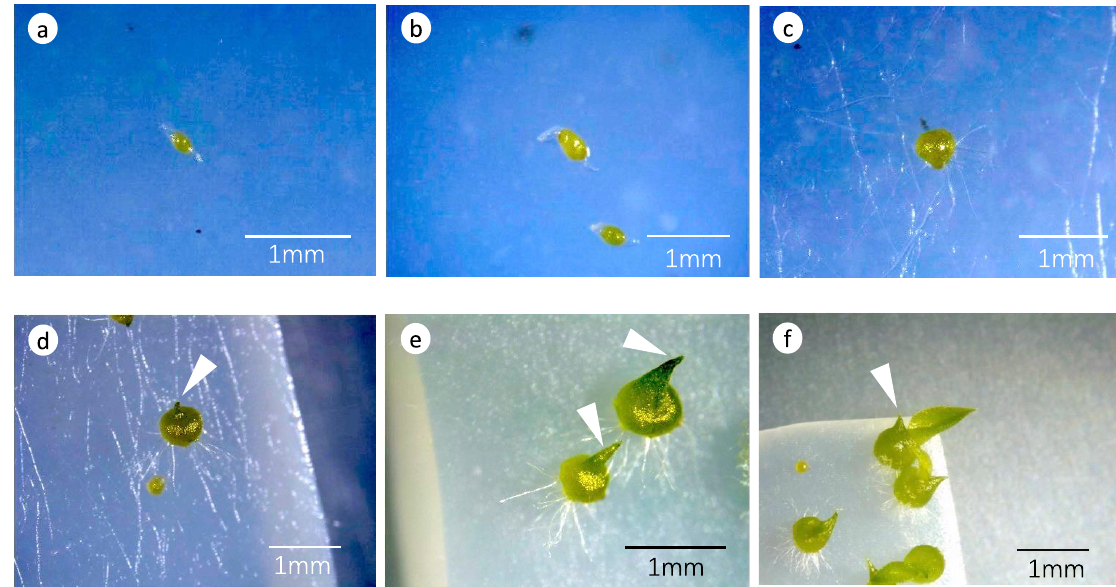
Figure 1. The six developmental stages of germinating Dendrobium officinale seeds. ( a ) Stage 0: no germination; ( b ) stage 1: an enlarged embryo with ruptured seed coat; ( c ) stage 2: a globular embryo (protocorm) with rhizoids; ( d ) stage 3: a protocorm with an apical meristem (arrow); ( e ) stage 4: emergence of the first leaf (arrow) (seedling formation); and ( f ) stage 5: a seedling with a second leaf (arrow) and further development.